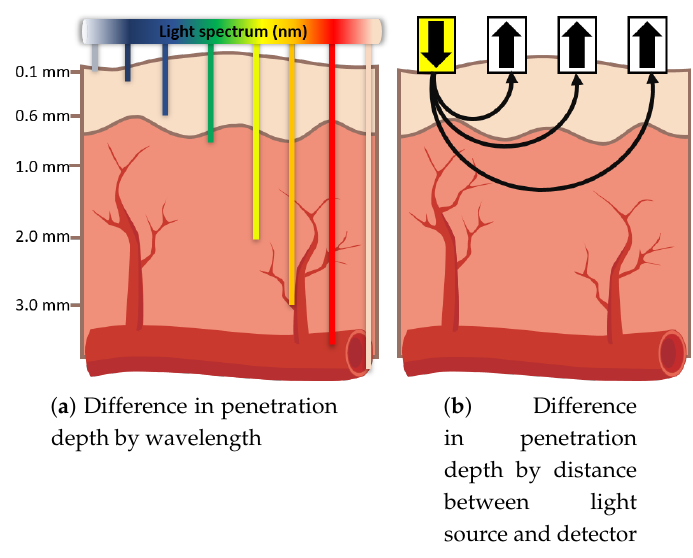
Figure 1. Illustrations of differences in penetration depth for Multispectral Skin Photomatrix (MSP) sensors by various wavelengths and distances between light source and